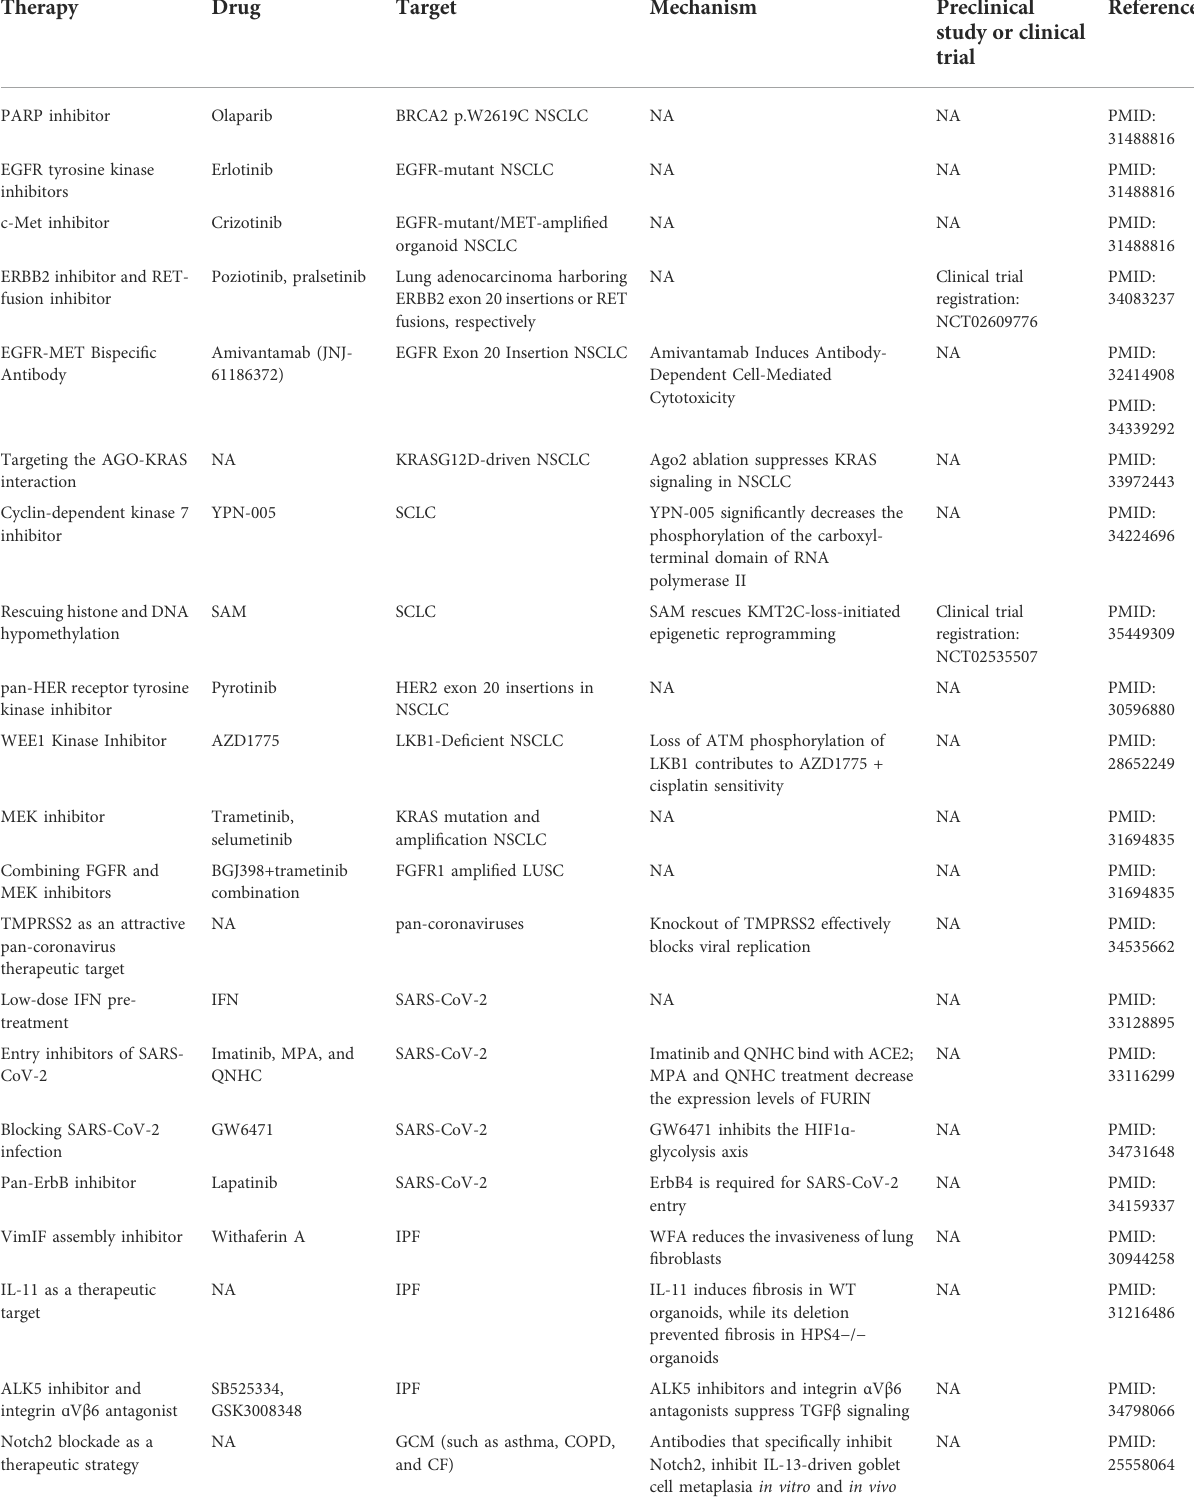
TABLE 2 Therapy strategy development based on lung